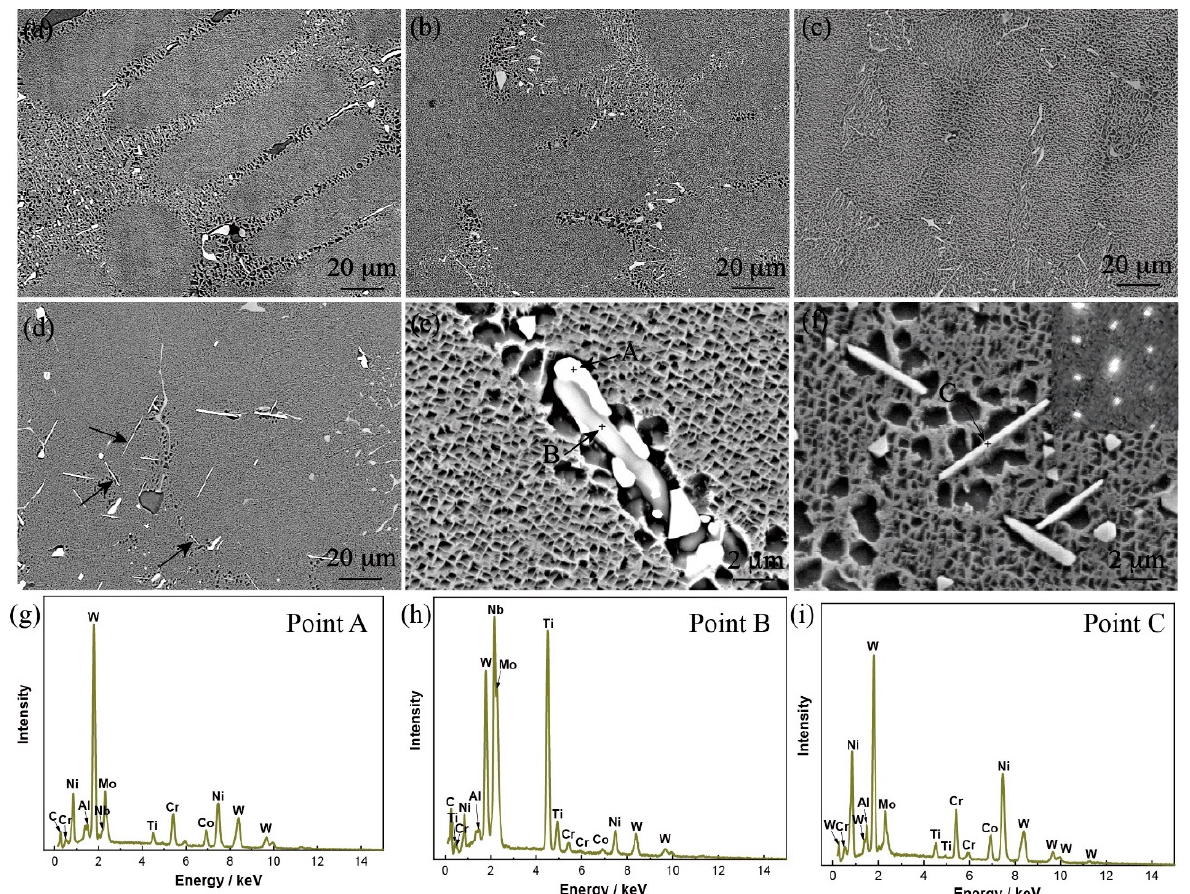
Figure 2. Microstructures of the heat-treated alloys with different Mo content: ( a ) Alloy I, ( b ) Alloy II, ( c ) Alloy III, ( d ) Alloy IV, ( e , f ) magnified images of Alloy IV alloy; ( g,h,i ) EDS results correspond to the points A, B, and C in ( e , f ). (The inset in ( f ) corresponds to the selected area electron diffraction pattern).